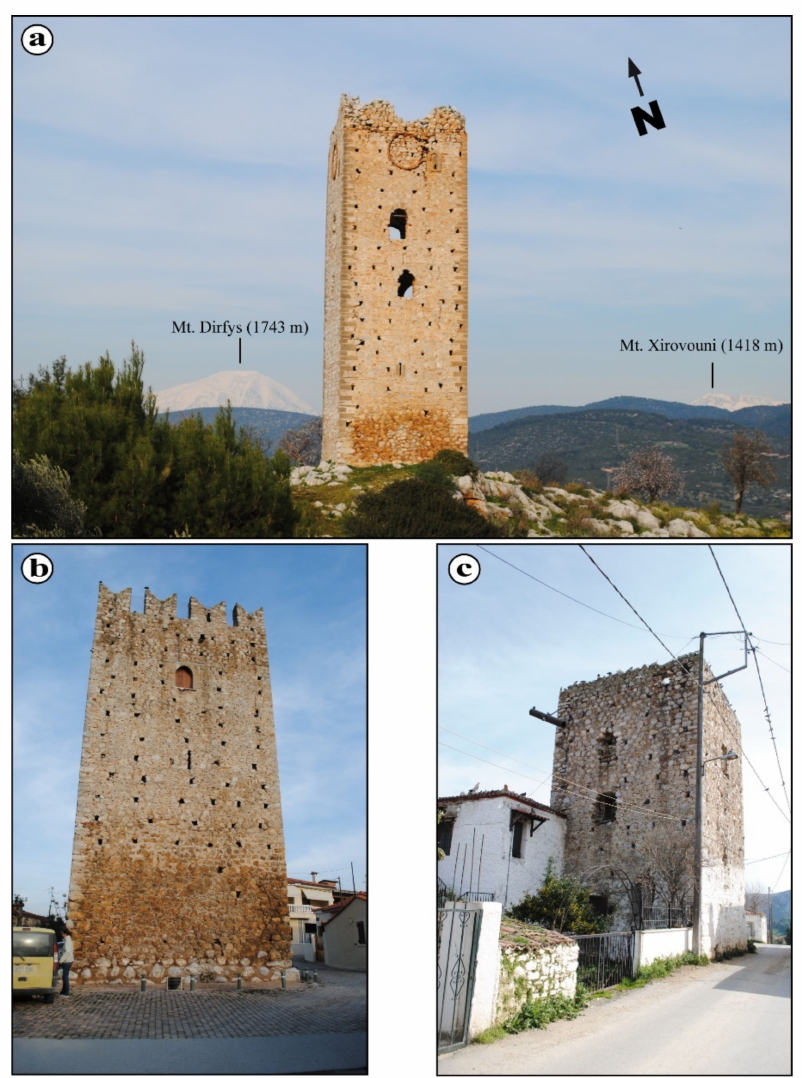
Figure 6. Venetian towers exist at ( a ) Phylla; ( b ) Vassiliko (lower reaches of the Lilas river) sand; and ( c ) at